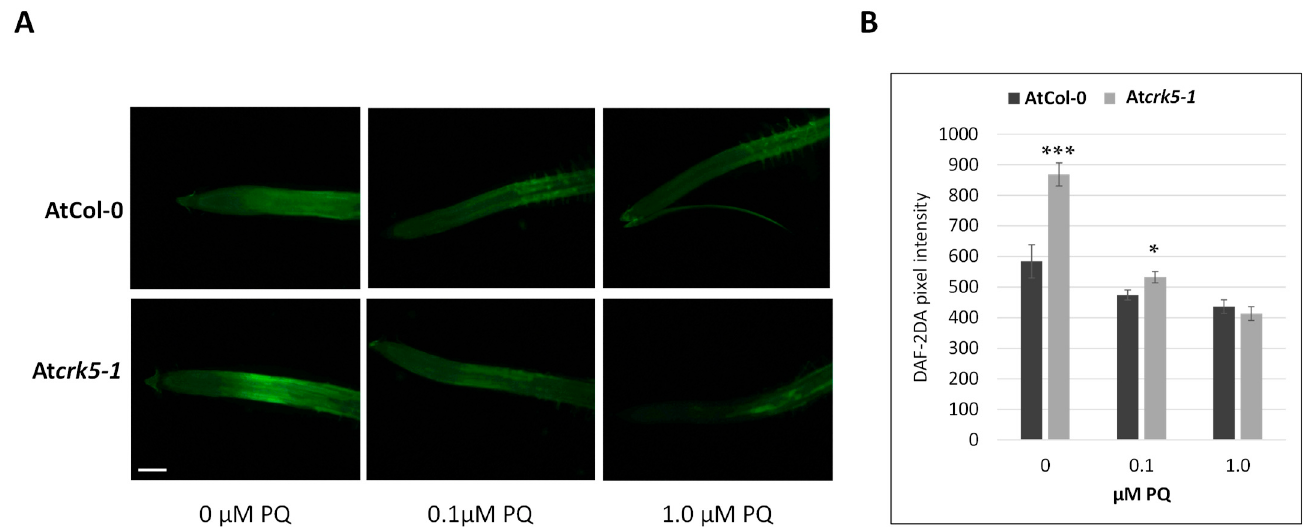
Figure 9. Detection of NO in wild type and mutant vertically grown Arabidopsis root apices without and with PQ treatment (0.1 or 1 µ M). NO content was measured by the fluorescence probe DAF-FM-DA (4-amino-5-methylamino-2 ′ ,7 ′ -difluorofluorescein diacetate) ( A , scale bar: 100 µ m) and expressed as pixel intensity ( B ). DAF-FM fluorescence was measured at two identical regions, cc. 200 µ m and 500 µ m far away from the root tips and averaged (see Figure 7). See that 1 µ M PQ concentration reduced the NO content of the At crk5-1 mutant to the wild type level. Bars indicate ± SE of measurements performed with at least 20 seedlings per each line. p -values were calculated with two-tailed Student’s t -test (* p ≤ 0.1; *** p ≤ 0.001). Two biologically independent experiments were carried out with similar statistical